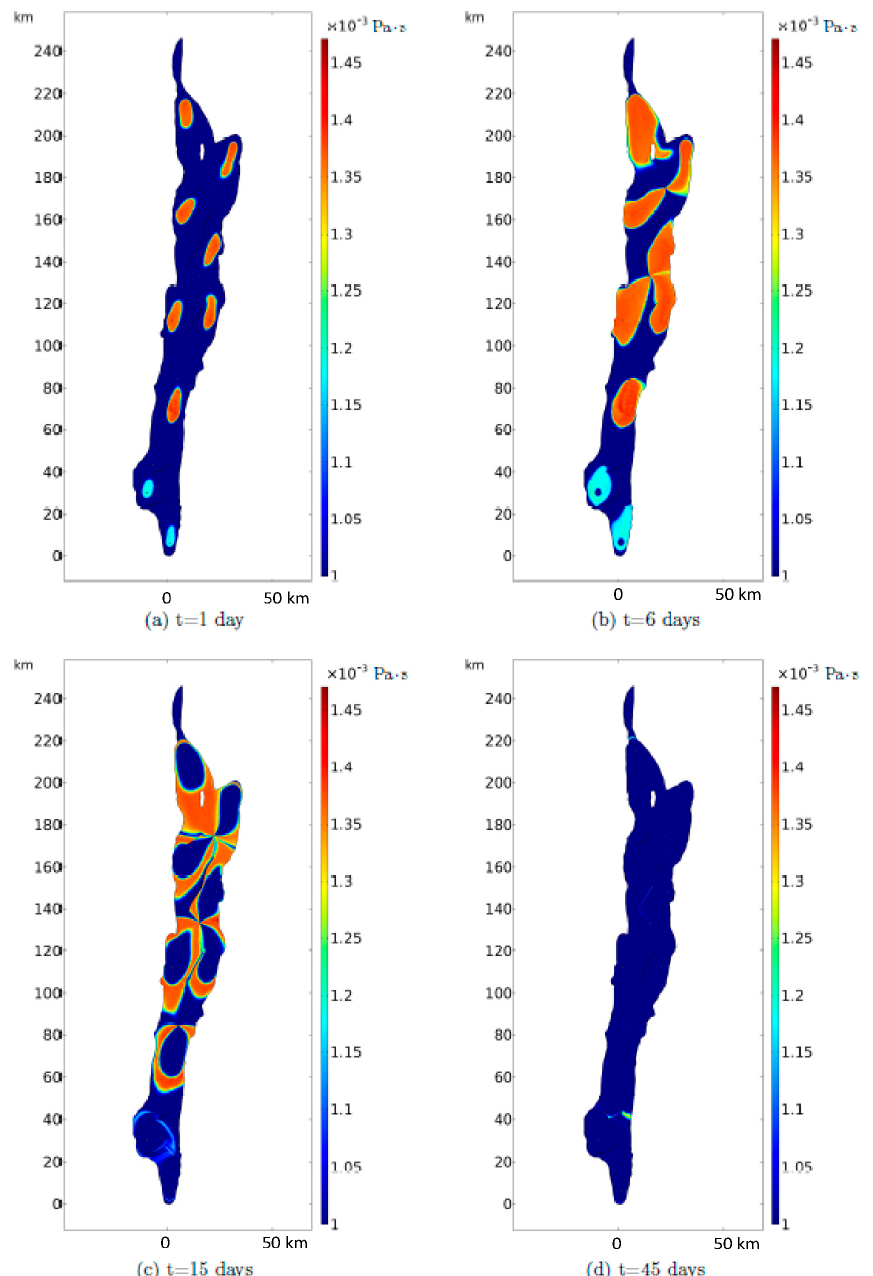
Figure 17. Polymer solution viscosity in Ghawar field at four different time steps of the